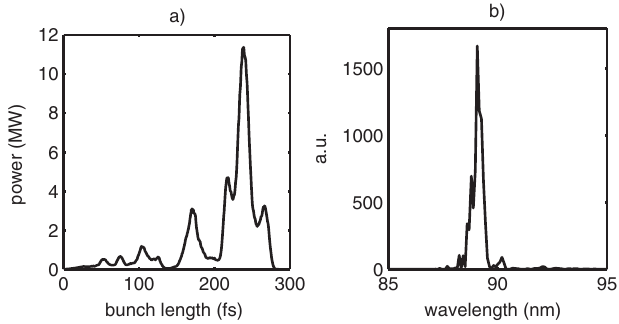
FIG. 6. Distribution of power along the bunch (a), and spectral power distribution (b), at the end of the radiator tuned to the 3rd